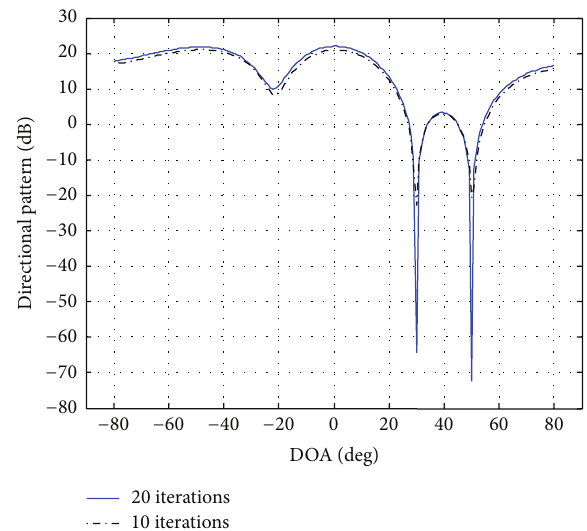
Figure 3: Power response DM-AIS with 10 and 20 iterations for user at 40 ∘ with interference at 30 ∘ and 50 ∘ .